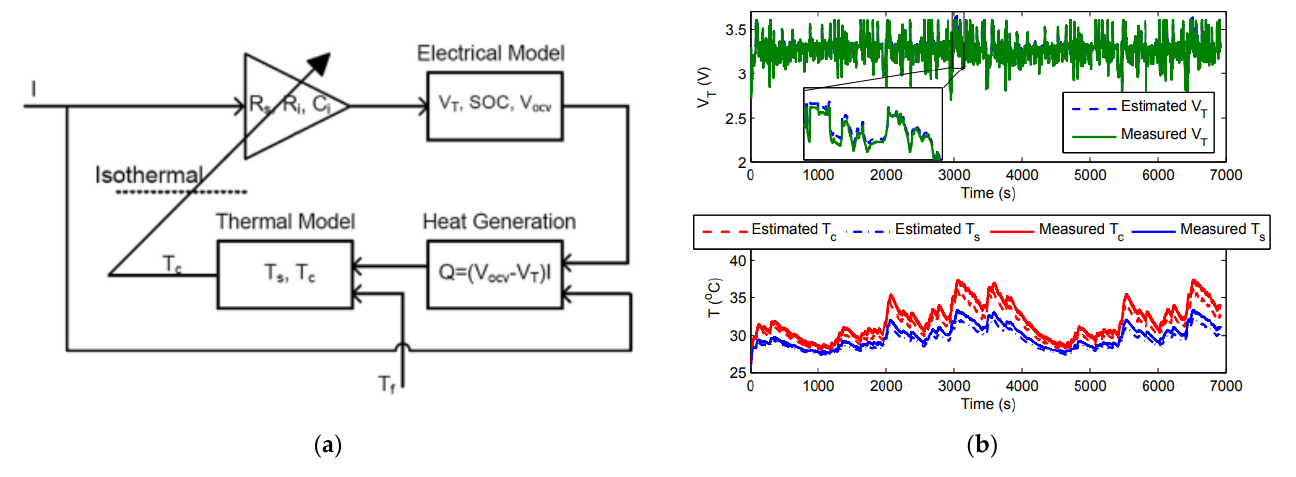
Figure 11. ( a ) A schematic representation of the electrical and thermal models. ( b ) Voltage and temperature estimation under the charge-sustaining cycle. Reprinted with permission from [66]. Copyright 2014 Elsevier.